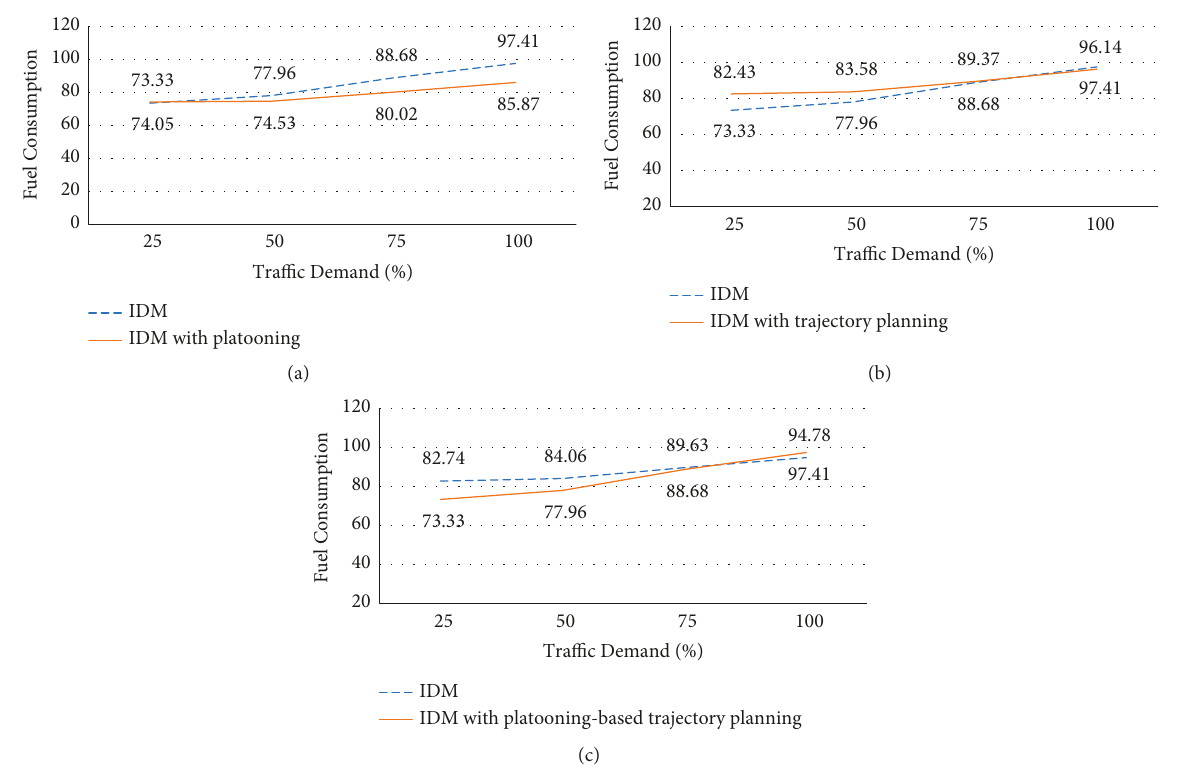
Figure 11: Average fuel consumption (ml) of CAVs in the superstreet. (a) Average fuel consumption for IDM and IDM with platooning. (b) Average fuel consumption for IDM and IDM with trajectory planning. (c) Average fuel consumption for IDM and IDM with platooning- based trajectory planning.